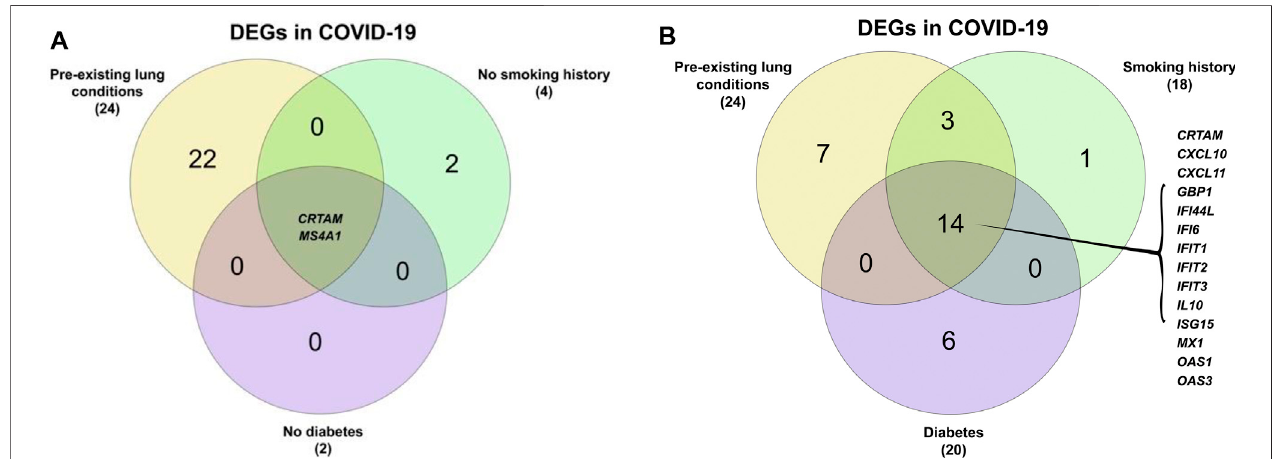
FIGURE 3 | Intersecting the differential expressed genes of (A) COVID-19 with pre-existing conditions, no smoking history, and no diabetes. (B) COVID-19 with pre-existing conditions, diabetes, and a smoking history.